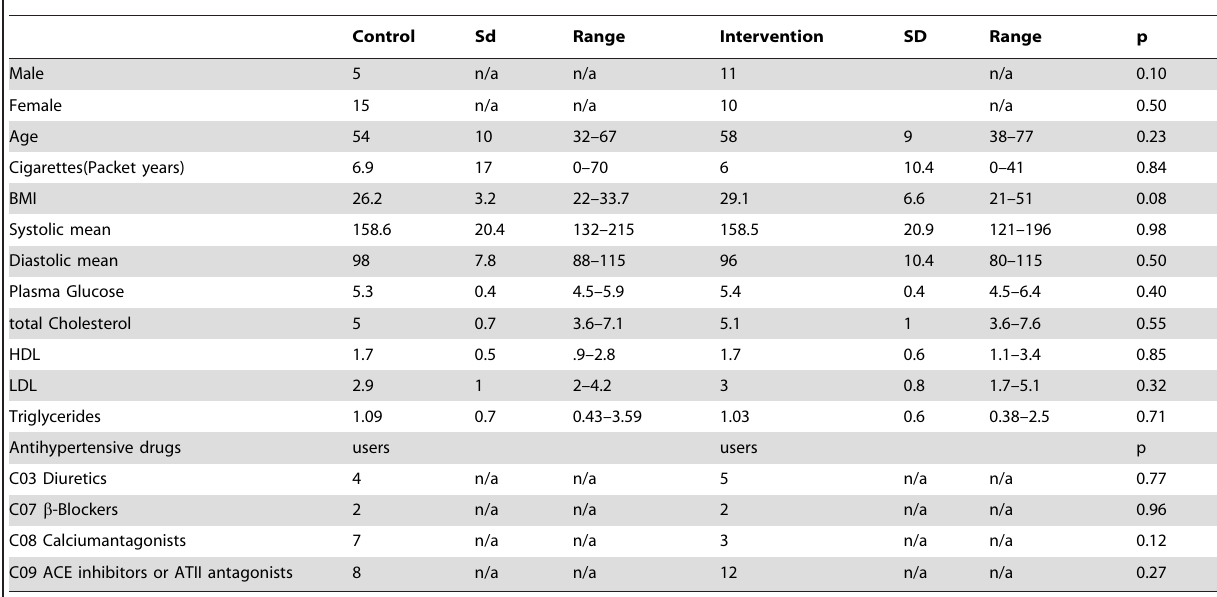
Table 2. Baseline characteristics of the control and interventional